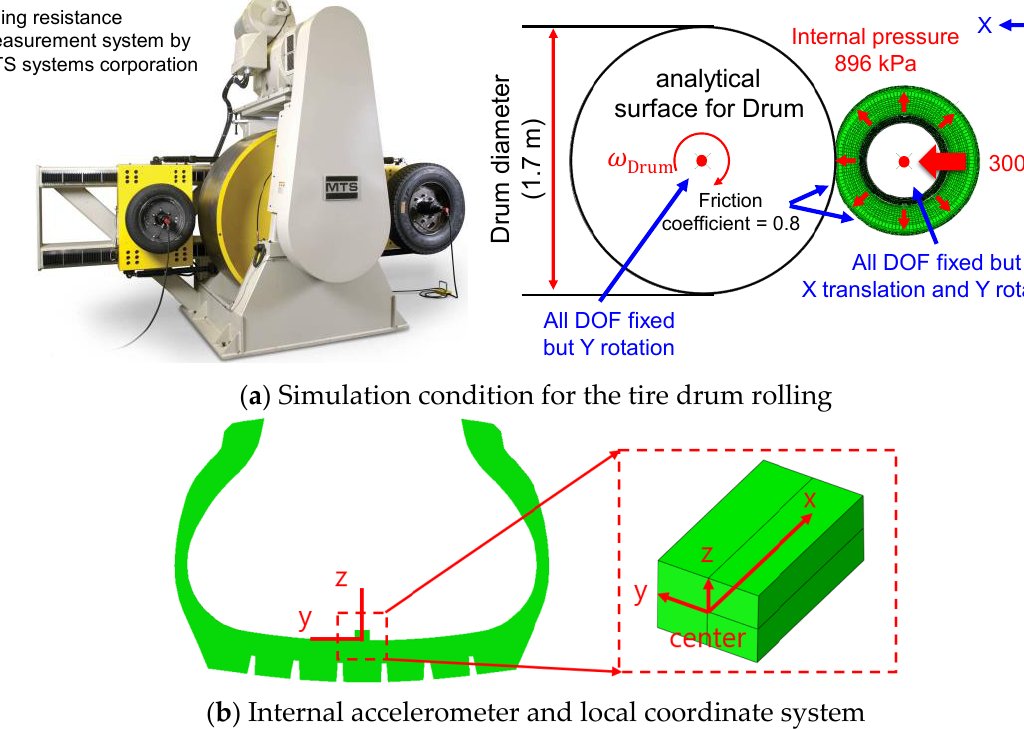
Figure 4. Comparison of tire internal acceleration under drum rolling